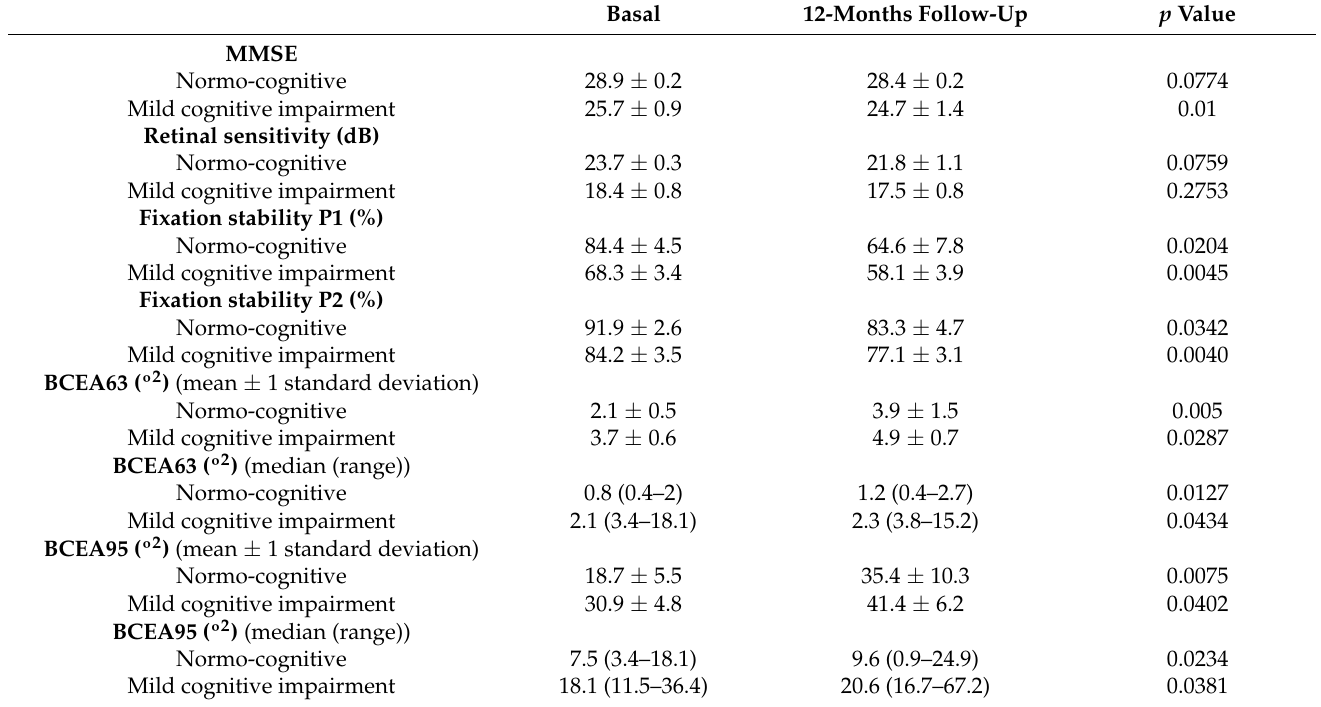
Table 4. MMSE and microperimetry parameters at 12 months